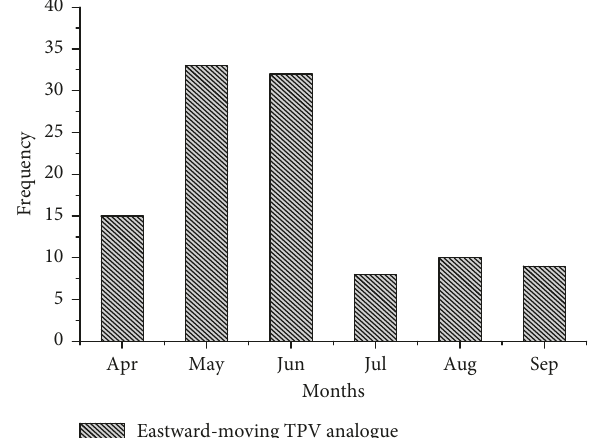
Figure 2: The monthly variation of the frequency with regard to the eastward-moving TPV category ( X -axis represents the month, and Y -axis represents vortex frequency (unit: